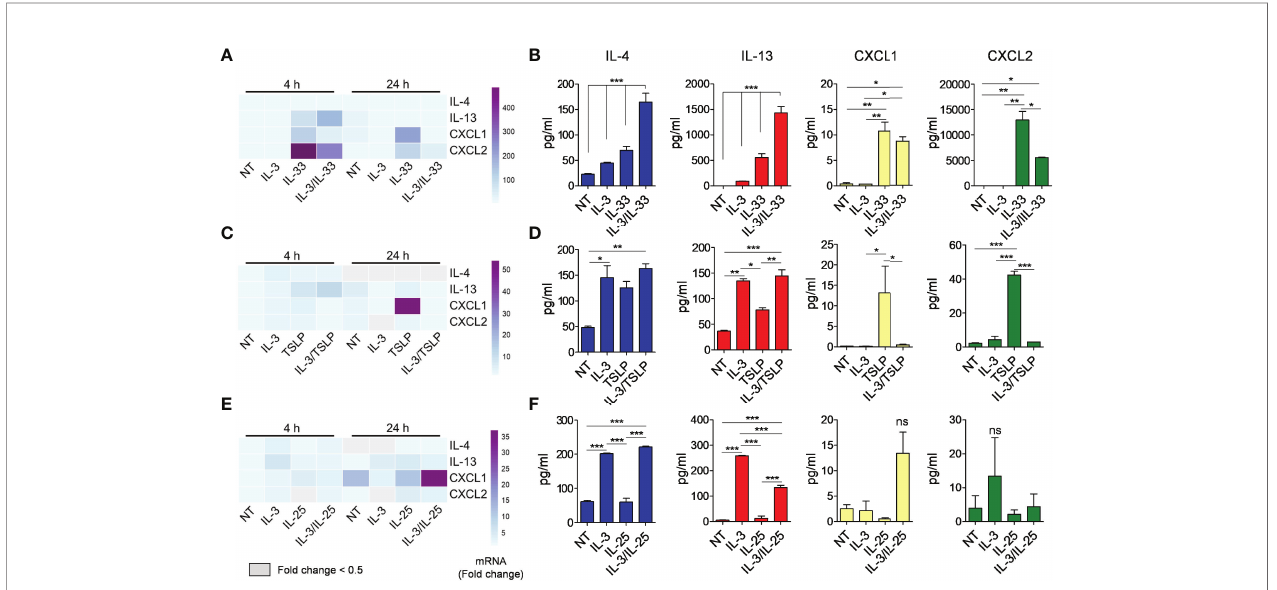
FIGURE 4 | Effects of rmIL-3 alone and in combination with rmIL-33, rmTSLP, or rmIL-25 on cytokine (IL-4, IL-13) and chemokine (CXCL1, CXCL2) mRNA expression and release from mBaso. Puri fi ed mBaso (10 6 cells/ml) were stimulated with rmIL-3 (1 ng/ml) alone and in combination with (A, B) rmIL-33 (10 ng/ml), (C, D) rmTSLP (10 ng/ml) or (E, F) rmIL-25 (10 ng/ml). (A, C, E) mRNA expression was assessed by qRT-PCR after 4 and 24 hours of stimulation. Data in heatmap represent the mean fold increase of mRNA normalized to HPRT and with respect to untreated (NT) controls at 4 h +/- SD. (B, D, F) Concentrations of IL-4, IL-13, CXCL1 and CXCL2 in culture supernatants of mBaso incubated (24 h at 37°C) with the indicated combinations were measured by ELISA. NT: not stimulated. Data represent the mean amount of released cytokines +/- SD in culture triplicates. One representative experiment out of at least two replicates is shown. * p < 0.05; ** p < 0.01; *** p < 0.001 ns, Not Signi fi